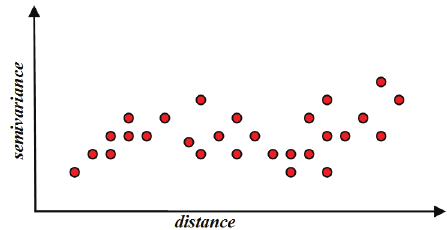
Figure 3 - Empirical semivariogram graph